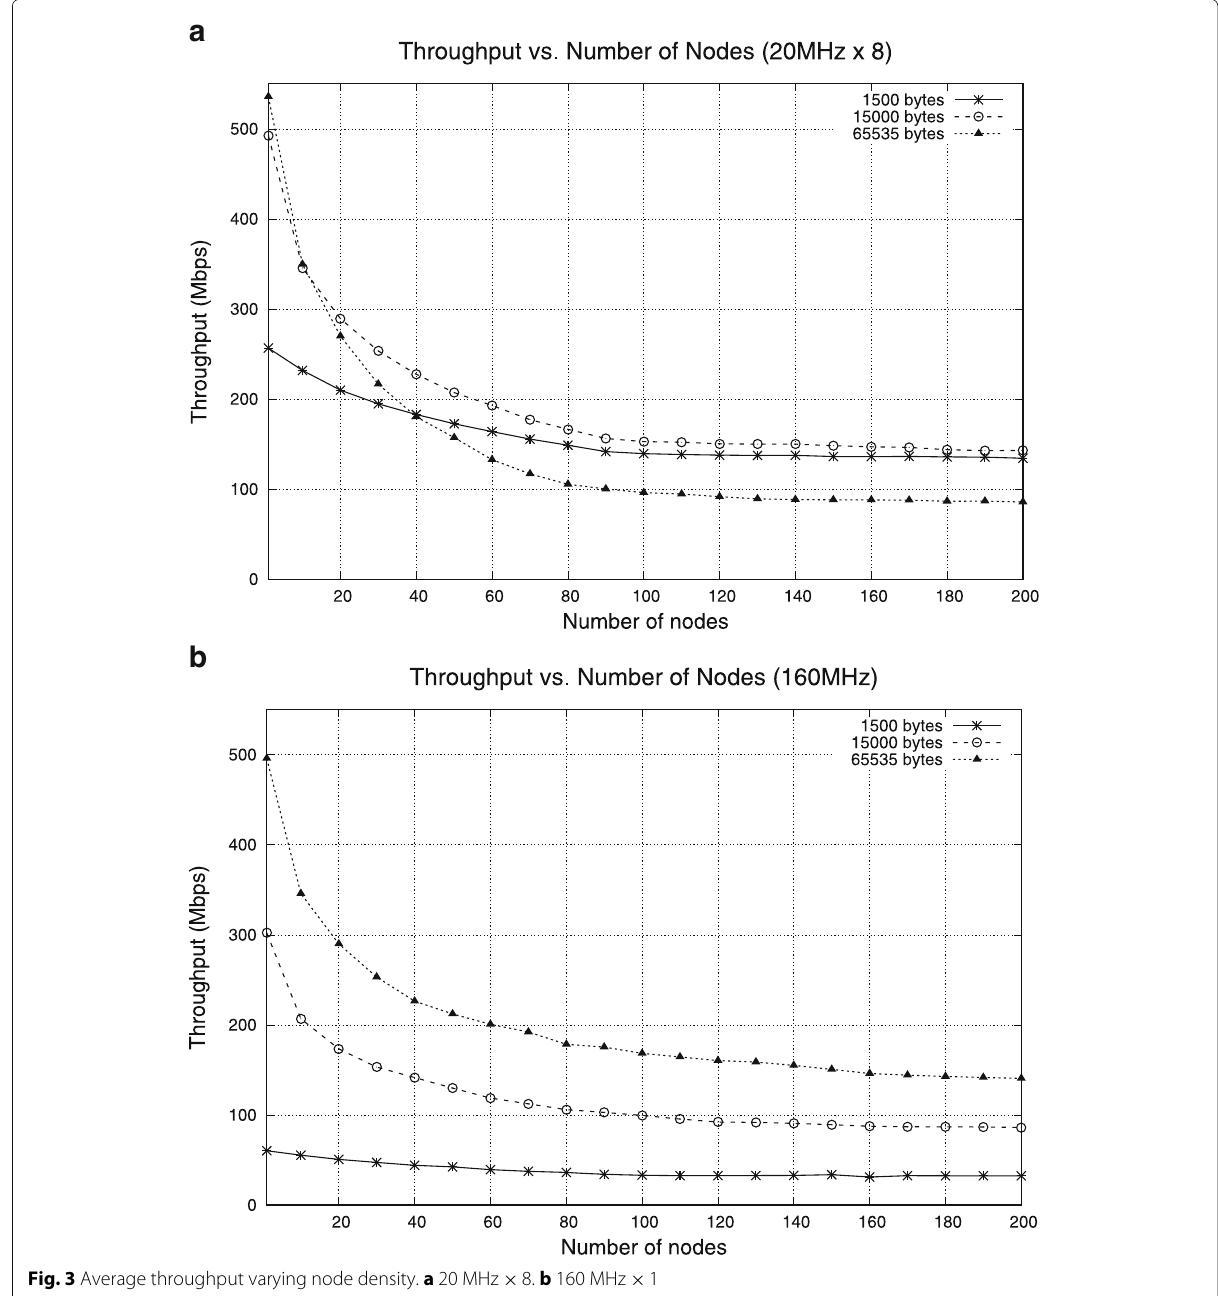
Fig. 3 Average throughput varying node density. a 20 MHz × 8. b 160 MHz ×